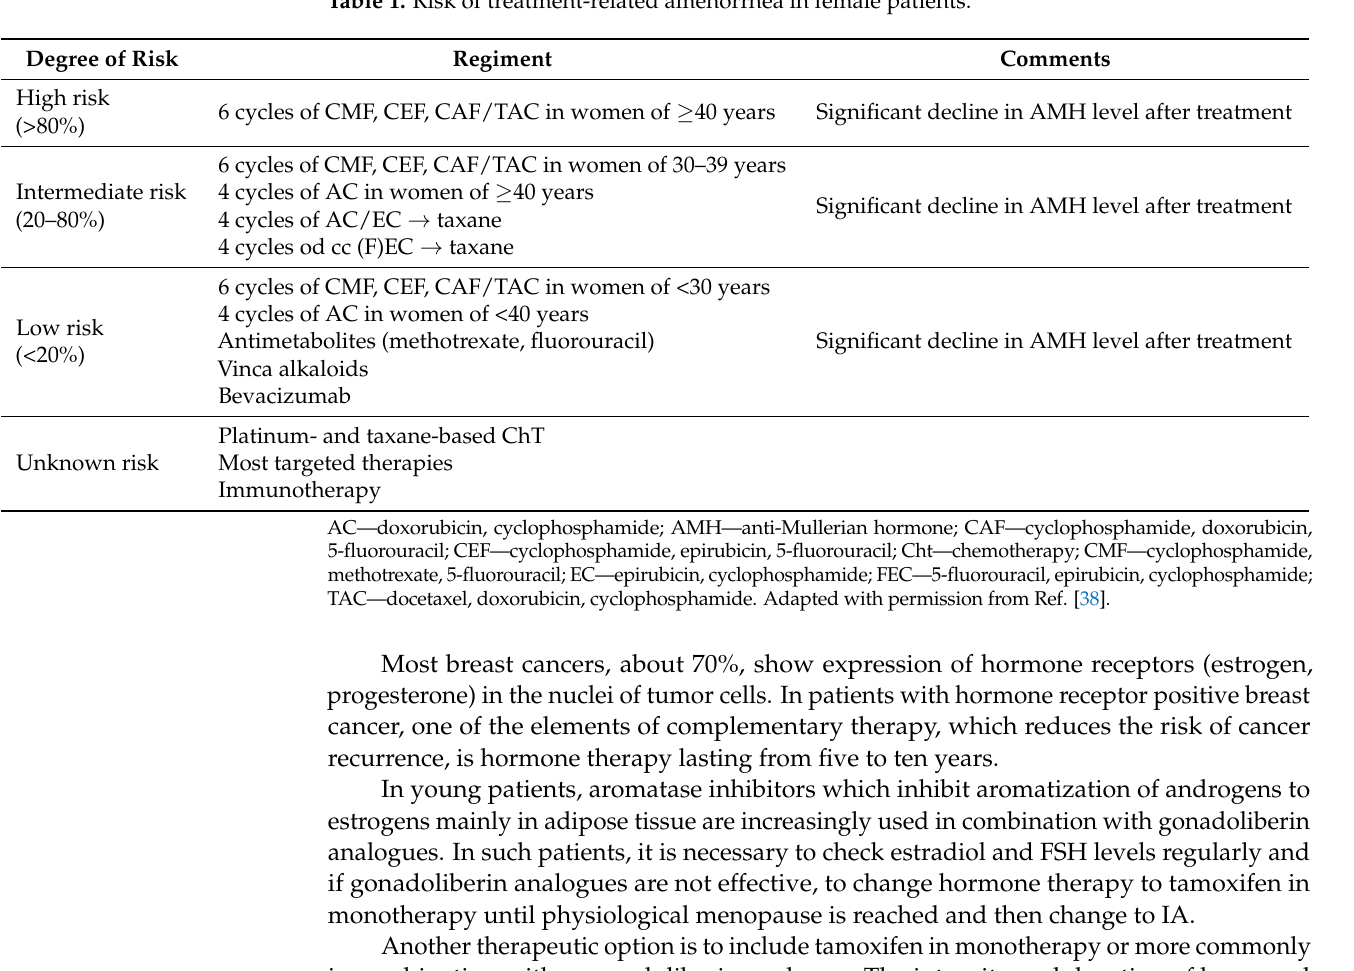
Table 1. Risk of treatment-related amenorrhea in female